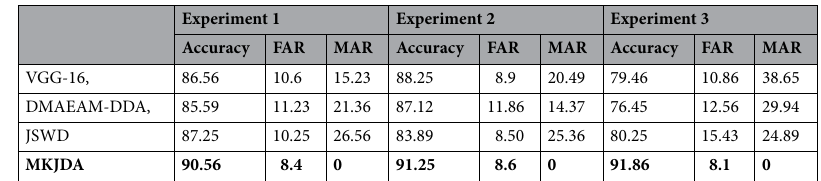
Table 11. Diagnostic results of experiments 1–3 considering trustworthy